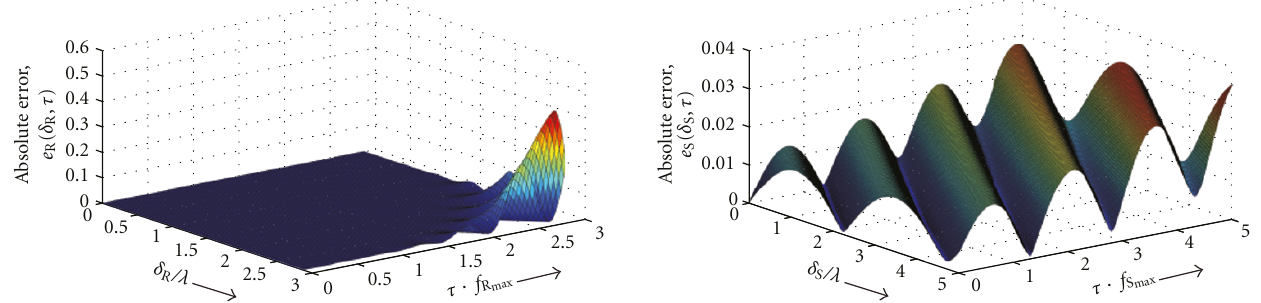
Figure 8: Absolute error e R ( δ R , τ ) = | ρ R ( δ R , τ ) − (cid:22) ρ R ( δ R , τ ) | by using the MMEA with K = L = 23 (isotropic scattering).